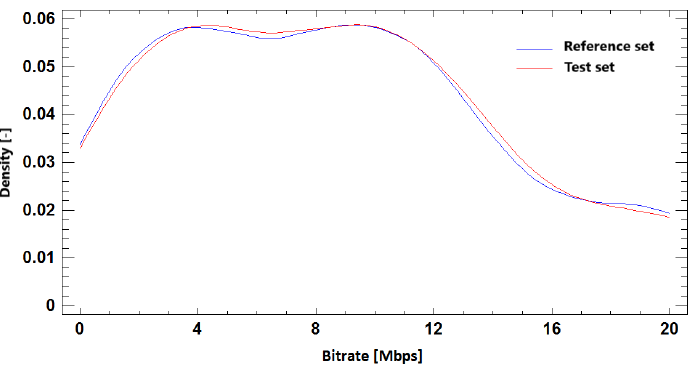
Figure 28. The probability density function for bitrate prediction based on MOS, Full HD + Ultra HD, H.264 +